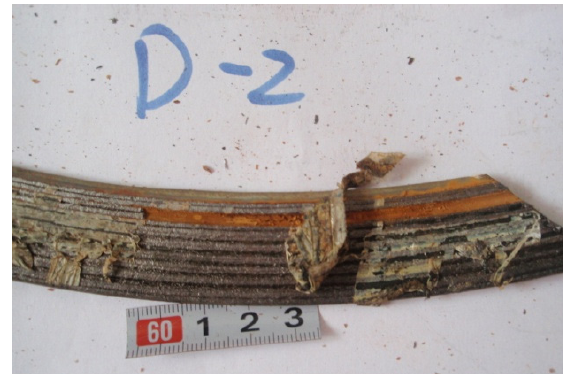
Figure 4. Typical flange leakage morphology.